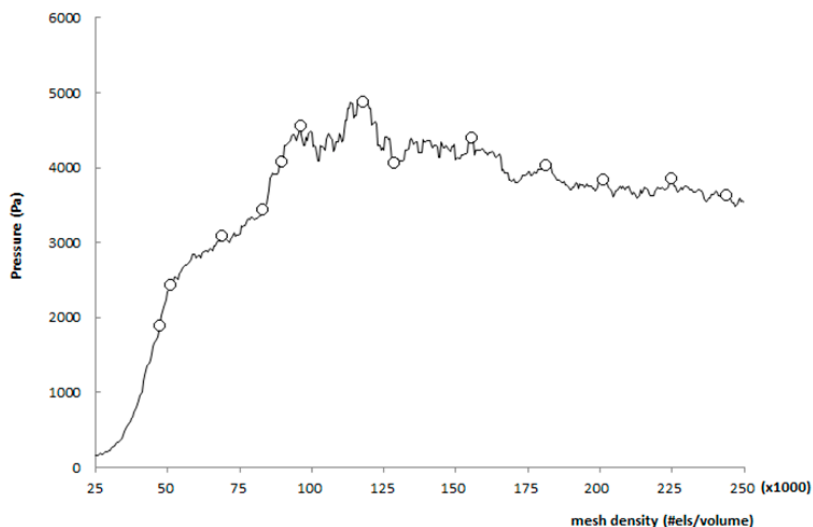
Figure 9. Mesh sensitivity analysis.